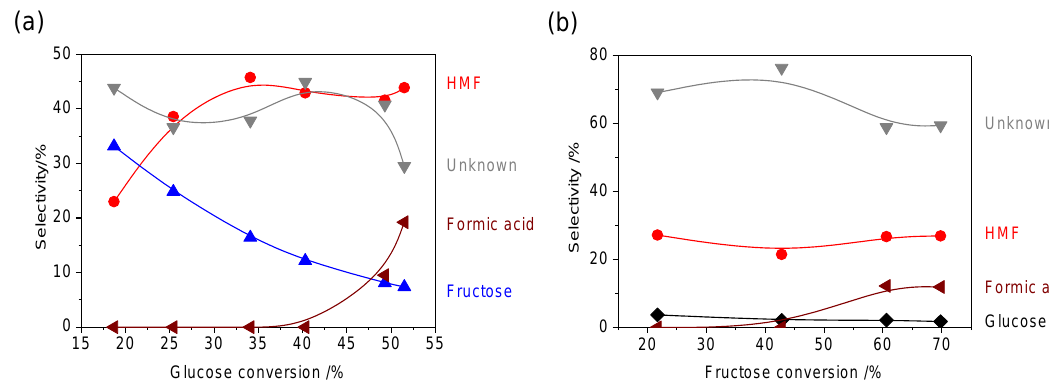
Figure 6. HMF selectivity vs. (a) glucose conversion and (b) fructose conversion over HNbWO 6 aggregated nanosheets.